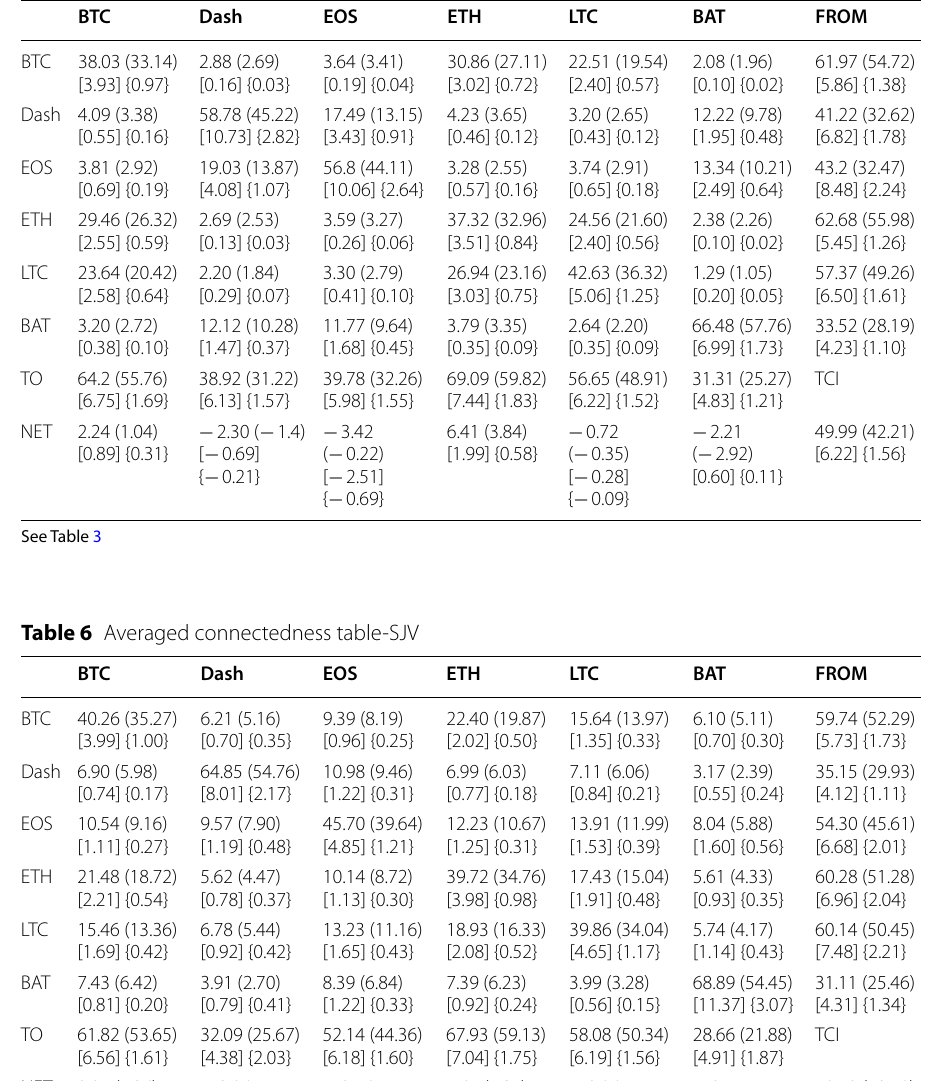
Table 5 Averaged connectedness table-RK